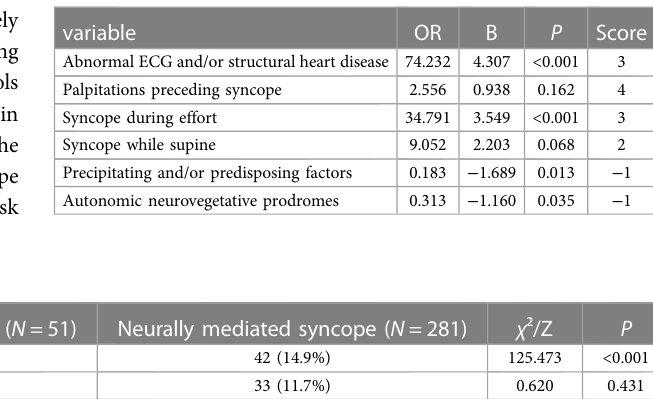
TABLE 5 The result of EGSYS risk factors on multivariable